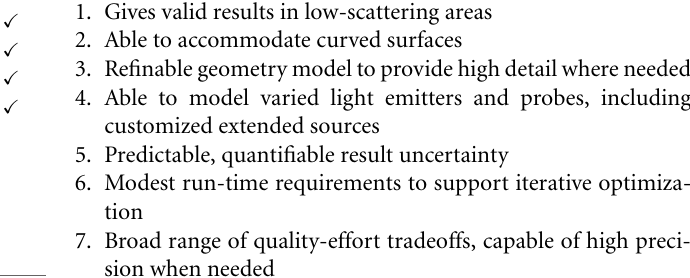
Table 1 | Controllable and non-controllable factors in PDT treatment planning, showing which parameters will alter the fluence field and hence require separate optical simulations ( * denotes limited range). Factor Controllable Impacts fluence Pre-tx In-tx